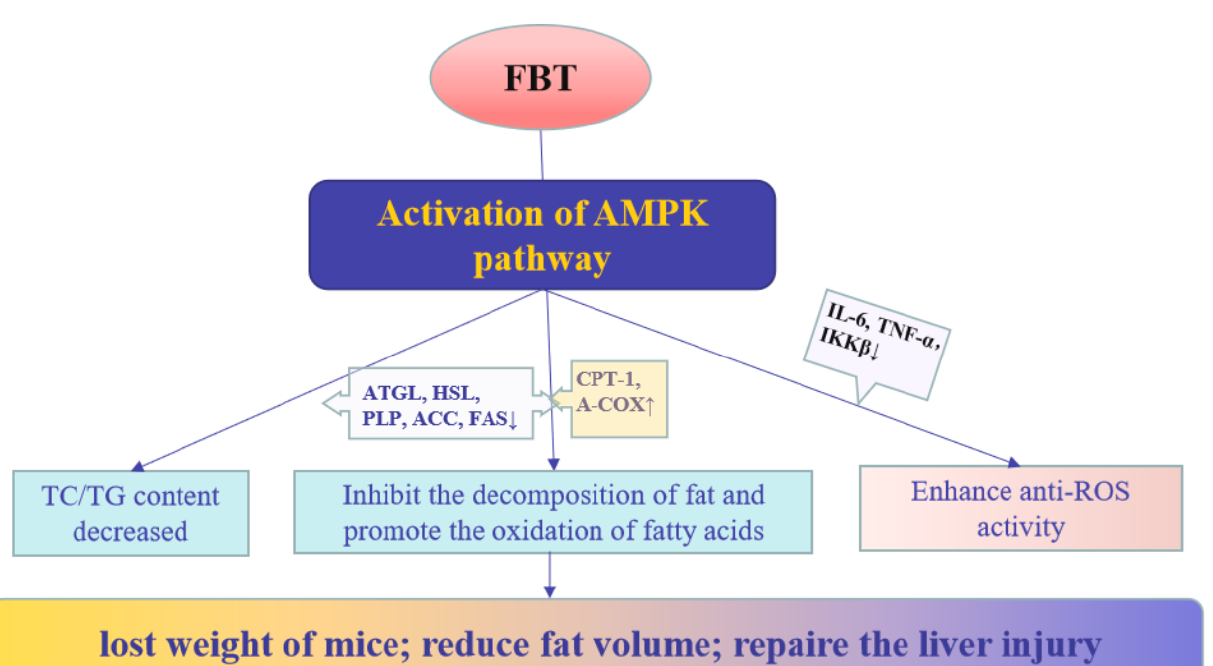
Figure 8. The lipid-lowering mechanism of FBT on fat metabolism in